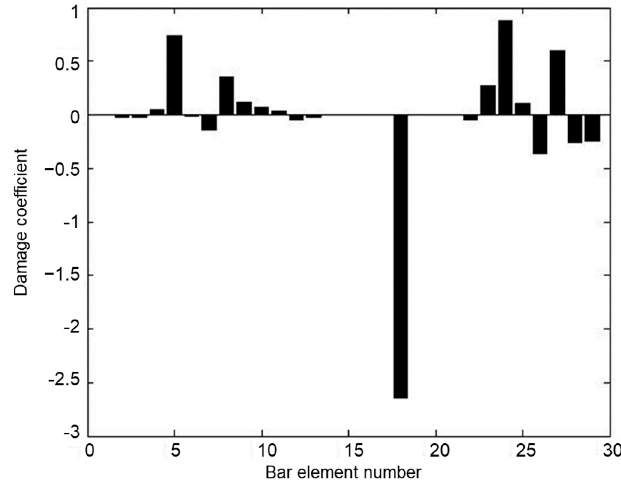
Figure 10. The damage coefficients obtained by the existing static sensitivity method.